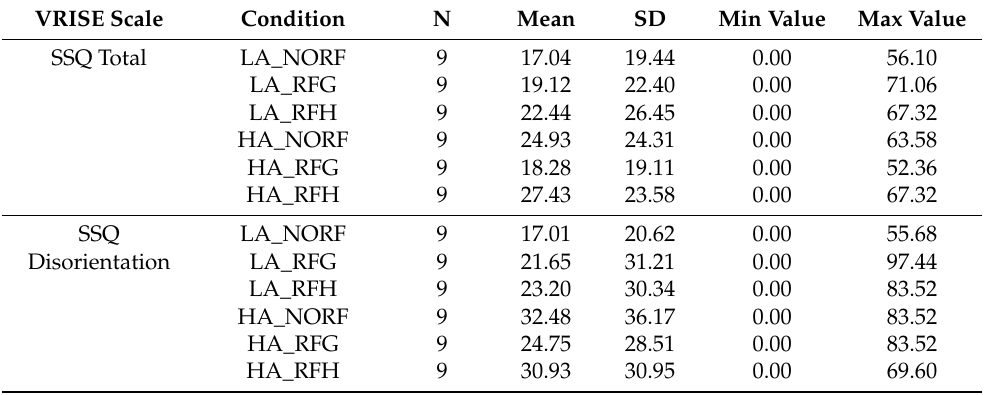
Table 16. Subjective VRISE levels assessed by the SSQ and VRNQ (VRISE Section) for participants who had normal vision and did use distance spectacles or contact lenses (during the experiment, they were wearing contact